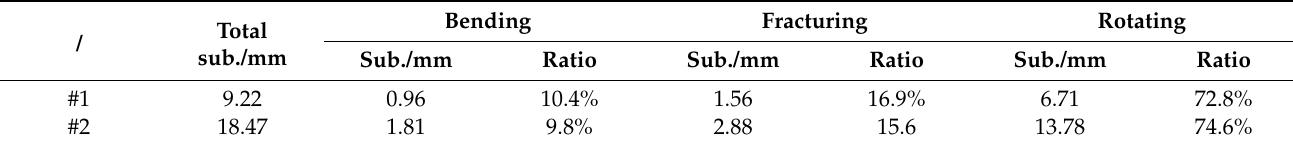
Table 3. Subsidence of the PKS in different stages.